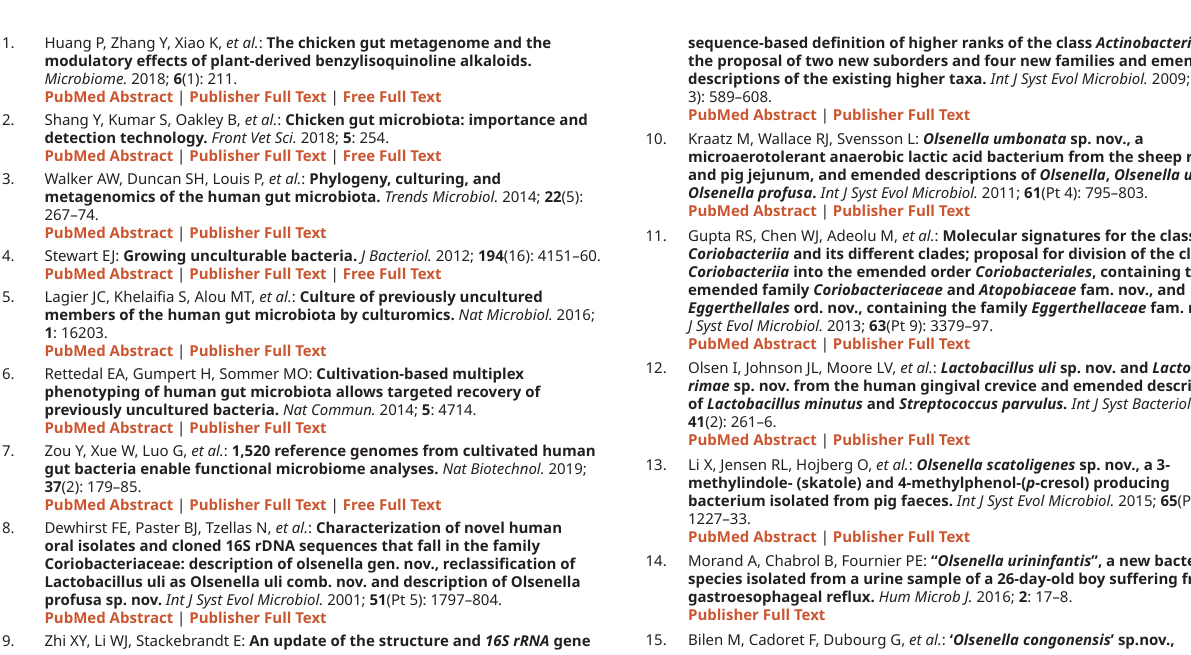
Figshare: Supplemental Data 1 (DSMZ and CCOS accession numbers of strain SW165 T ), https://doi.org/10.6084/m9.figshare. 12793610.v1 53